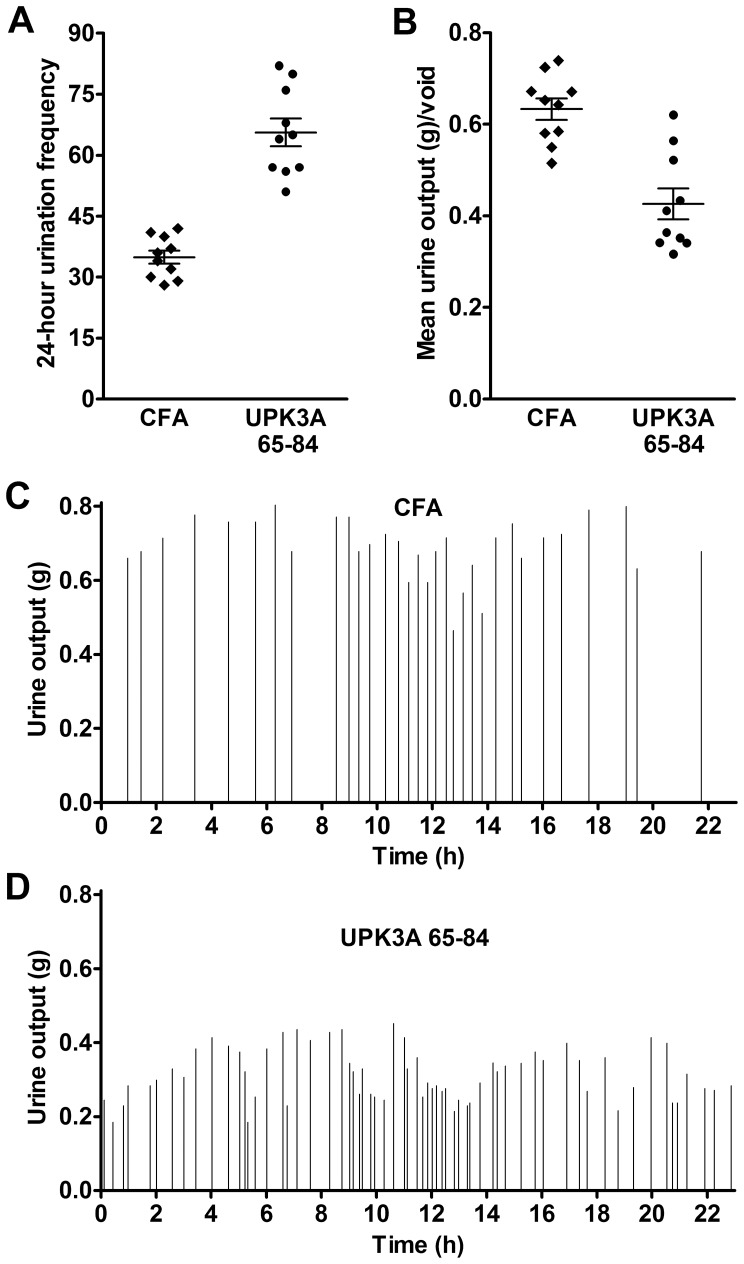
Bladder dysfunction in mice immunized with UPK3A 65–84.(A) 24-hour micturition frequencies were significantly higher 5 weeks after immunization of female BALB/c mice with UPK3A 65–84 compared to control mice immunized with CFA (p<0.0001). (B) Inversely, mean urine output/micturition was significantly lower in mice immunized with UPK3A 65–84 compared with control mice immunized with CFA (p = 0.0001). Error bars indicate plus and minus SEM. (C–D) The graphs show the urine production and frequency of a representative individual mouse immunized with UPK3A 65–84 (C) and one immunized with CFA (D).